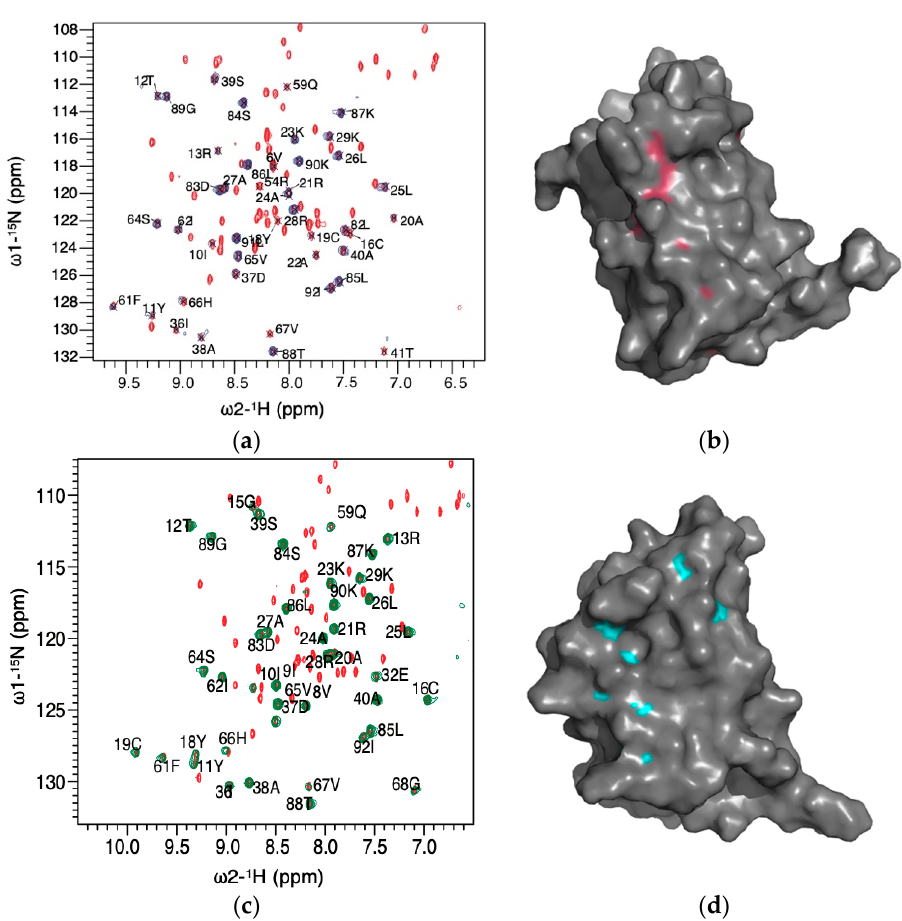
Figure 7. Gd(III) relaxation of GRX shows possible dimer interface. ( a ) 15 N-HSQC spectrum with select assignments shown 0.5 eq Ag metalated GRX (red), 0.5 eq Ag metalated GRX with 3 mM Gd- DTPA (blue); ( b ) solvent exposed residues protected from broadening mapped onto GRX (pink); ( c ) apoGRX (red) with 3 mM Gd-DTPA (green); ( d ) solvent exposed residues protected from broaden- ing mapped onto the apo structure (teal) (PDB: 2KHP).